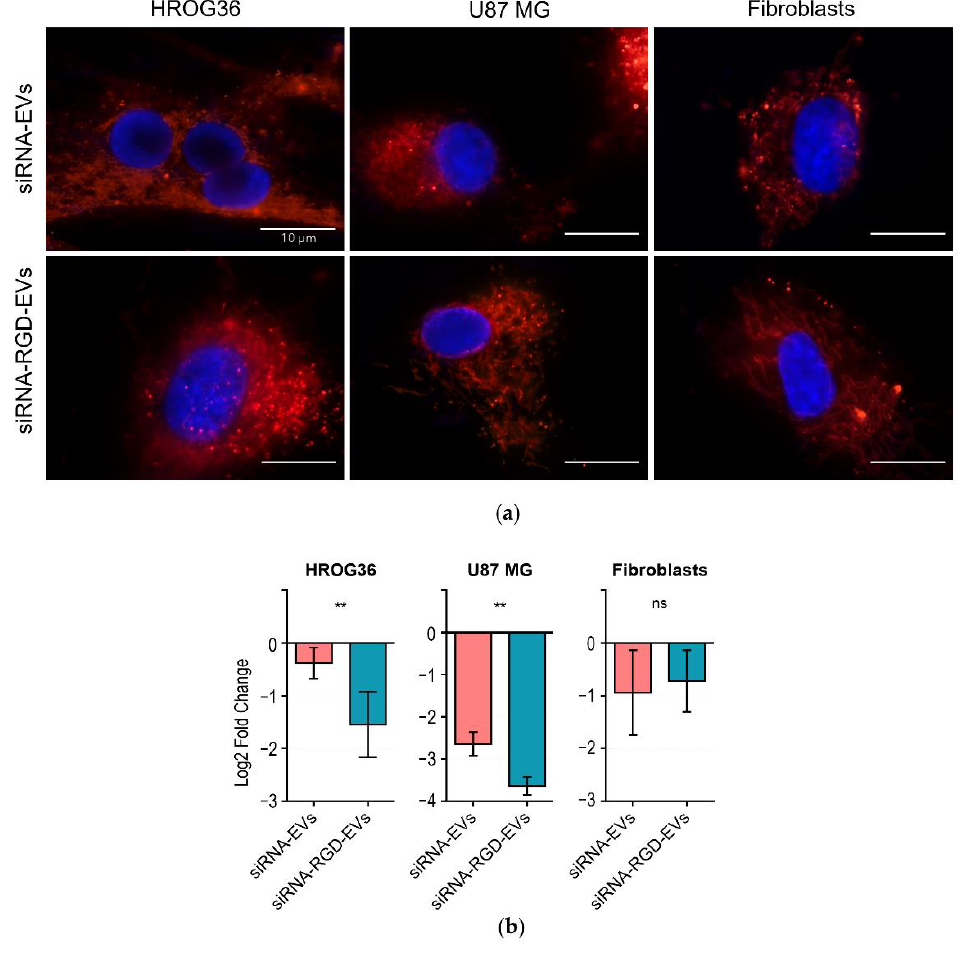
Figure 5. siRNA delivery to GBM and fibroblast cells. ( a ) Representative images of the internalisation of siRNA-loaded EVs by GBM and fibroblast cells. The accumulation of red fluorescent dye shows the distribution of siRNA molecules throughout the cells following 4 h of treatment. ( b ) RT-qPCR results summary. siRNA-loaded RGD-EVs caused significantly stronger GAPDH knockdown in GBM cells but not in fibroblasts. n = 6; ** p < 0.01.